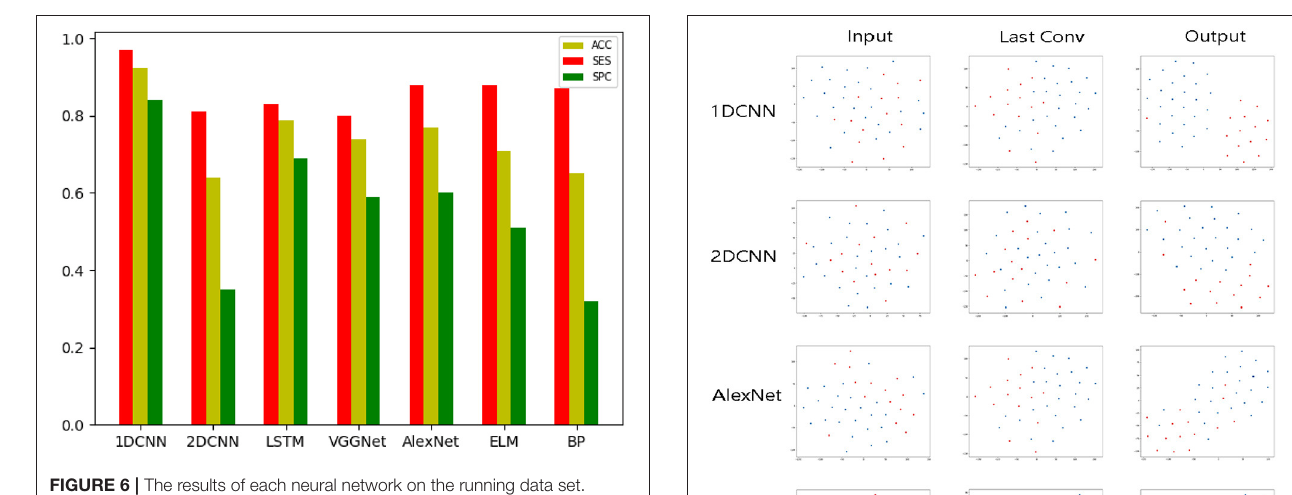
FIGURE 6 | The results of each neural network on the running data set.